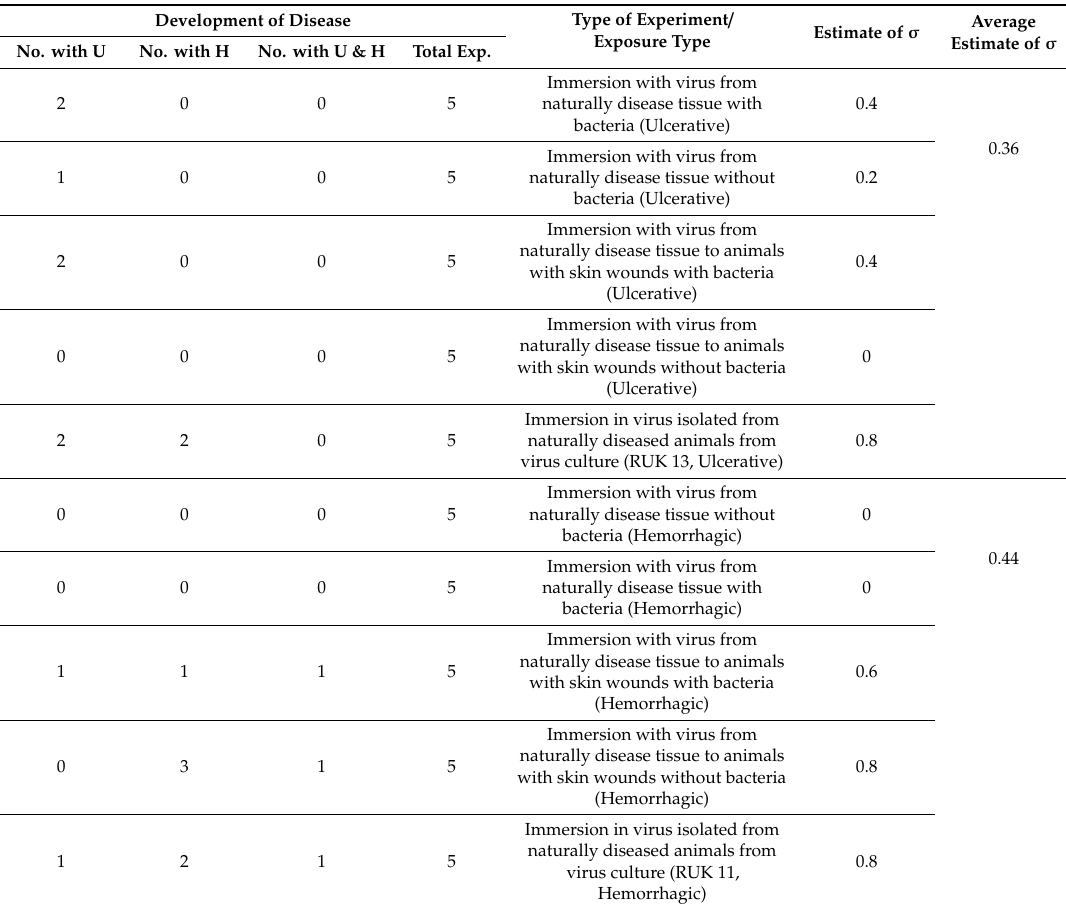
Table 2. Estimates for σ derived from the literature, taking into account the di ff erent disease syndromes and type of syndrome that the virus was obtained from. U indicates the ulcerative form of the disease; H is the hemorrhagic form. The estimate of σ is simply the prevalence of the disease based on the presence of the signs of disease when the experiment terminated. The average estimate of σ is simply the mean of the estimates for each type of virus used for exposure. Development of disease data and type of experiment information are summarized from Tables 3–5 of Cunningham et al.